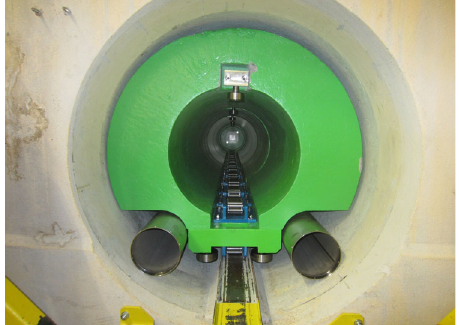
FIG. 6. Front photo of the PSB dump cavity, taken during the insertion of the new shielding blocks in October 2013. The concrete shielding blocks are visible, together with the two air inlet ducts as well as the lower and upper skates.